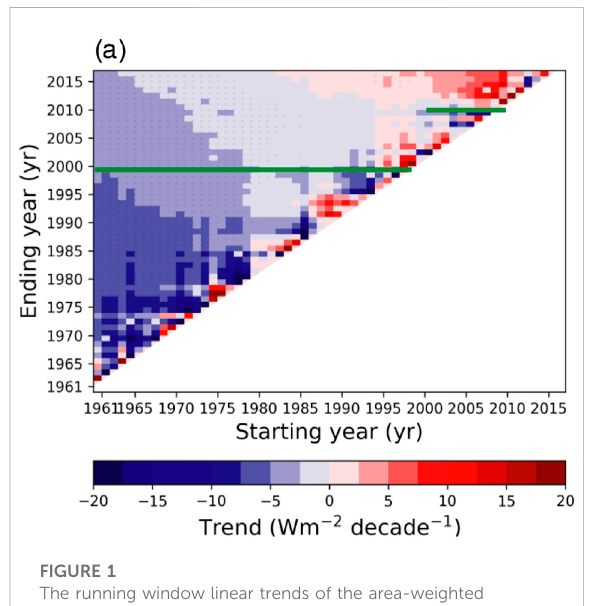
FIGURE 1 The running window linear trends of the area-weighted average GSR in eastern China. The x -axis denotes the starting year oftherunningwindow,whilethe y -axisdenotestheendingyearof the running window. Asterisk indicates that the trends are statistically signi fi cant at the 95% con fi dence level.